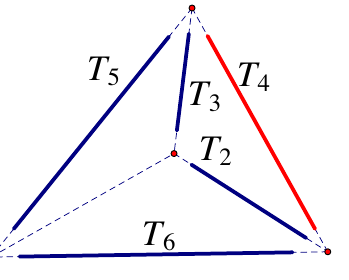
Figure 57. Any 5 trees on edges of a tetrahedron are all incident on a shared hinge